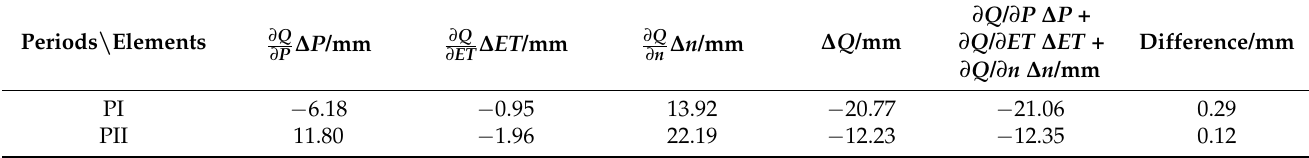
Table 6. Identification of attribution of runoff changes in the Weihe River basin.